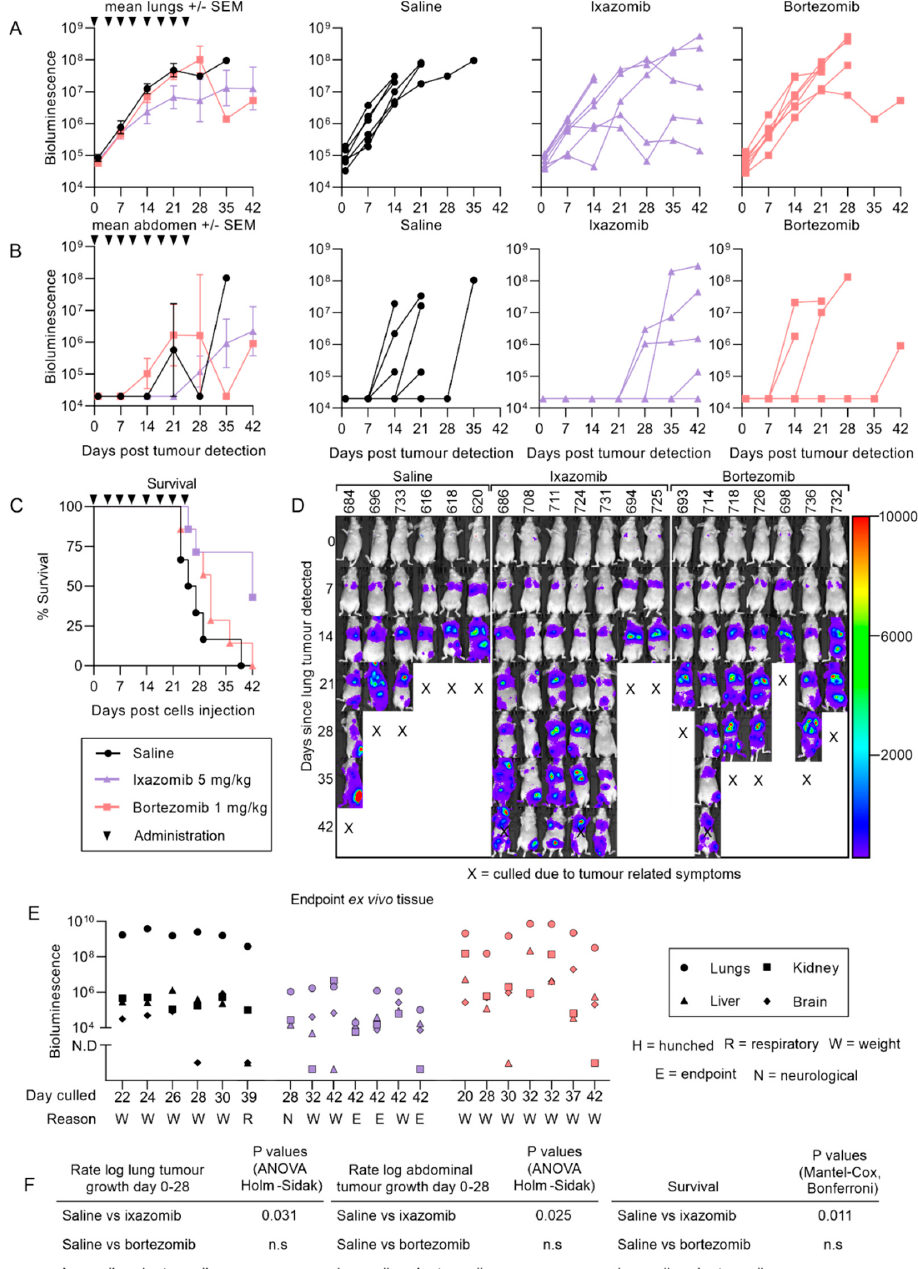
Figure 5 . Ixazomib reduces the growth of pulmonary and abdominal metastases and enhances the survival of mice bearing 143B-luc tumors. Mice were injected with 143B-luc cells intravenously, ranked based on their lung bioluminescence when this was detected (which was three or seven days later) and alternately distributed among treatment groups. Mice were imaged once per week thereafter, to monitor pulmonary ( A ) and abdominal ( B ) metastases. A Kaplan Meier curve was used to compare survival time between treatment groups ( C ). Compiled images of bioluminescence representing tumor growth starting from the day the tumor was detected until the endpoint of the experiment ( D ). When tumor related symptoms required the mouse to be euthanized or at the endpoint of the experiment, lungs, liver, kidney and brains were removed from mice and imaged for tumors by bioluminescence ex vivo to compare overall tumor burden in each mouse between treatment groups ( E ). Rates of growth of tumors and survival between treatment groups were compared ( F ). (n = 6 for saline and 7 for ixazomib and bortezomib, +/ − SEM).